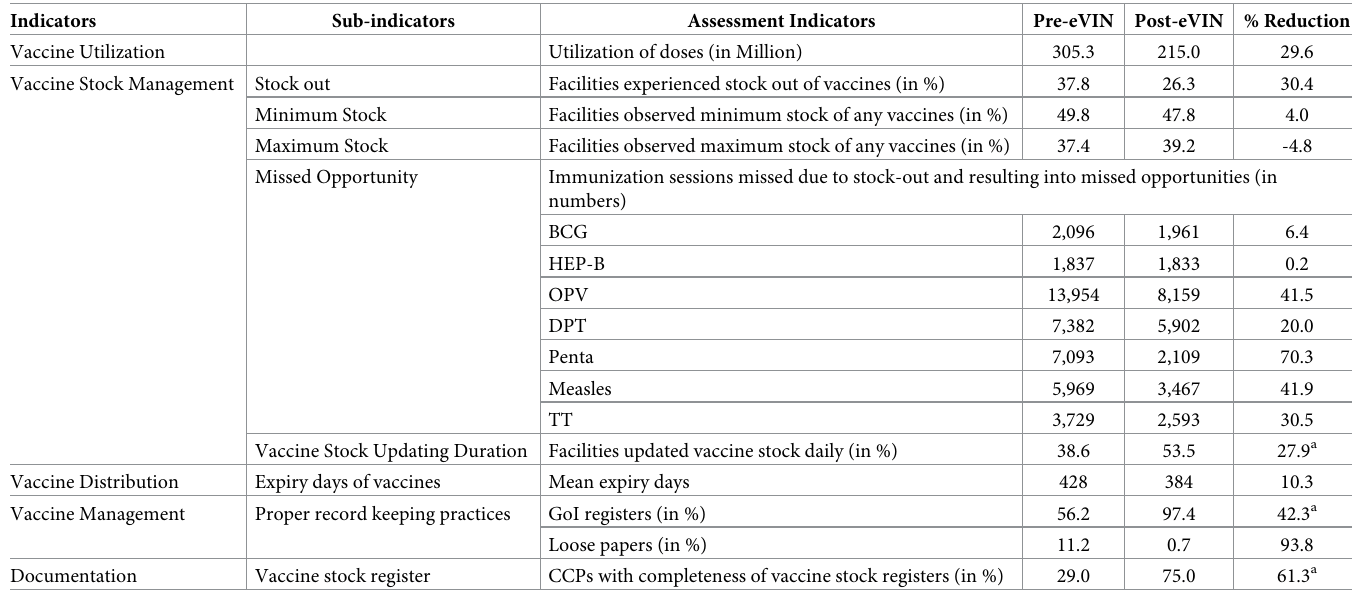
Table 2. Summary of results of indicators evaluated for programmatic assessment of